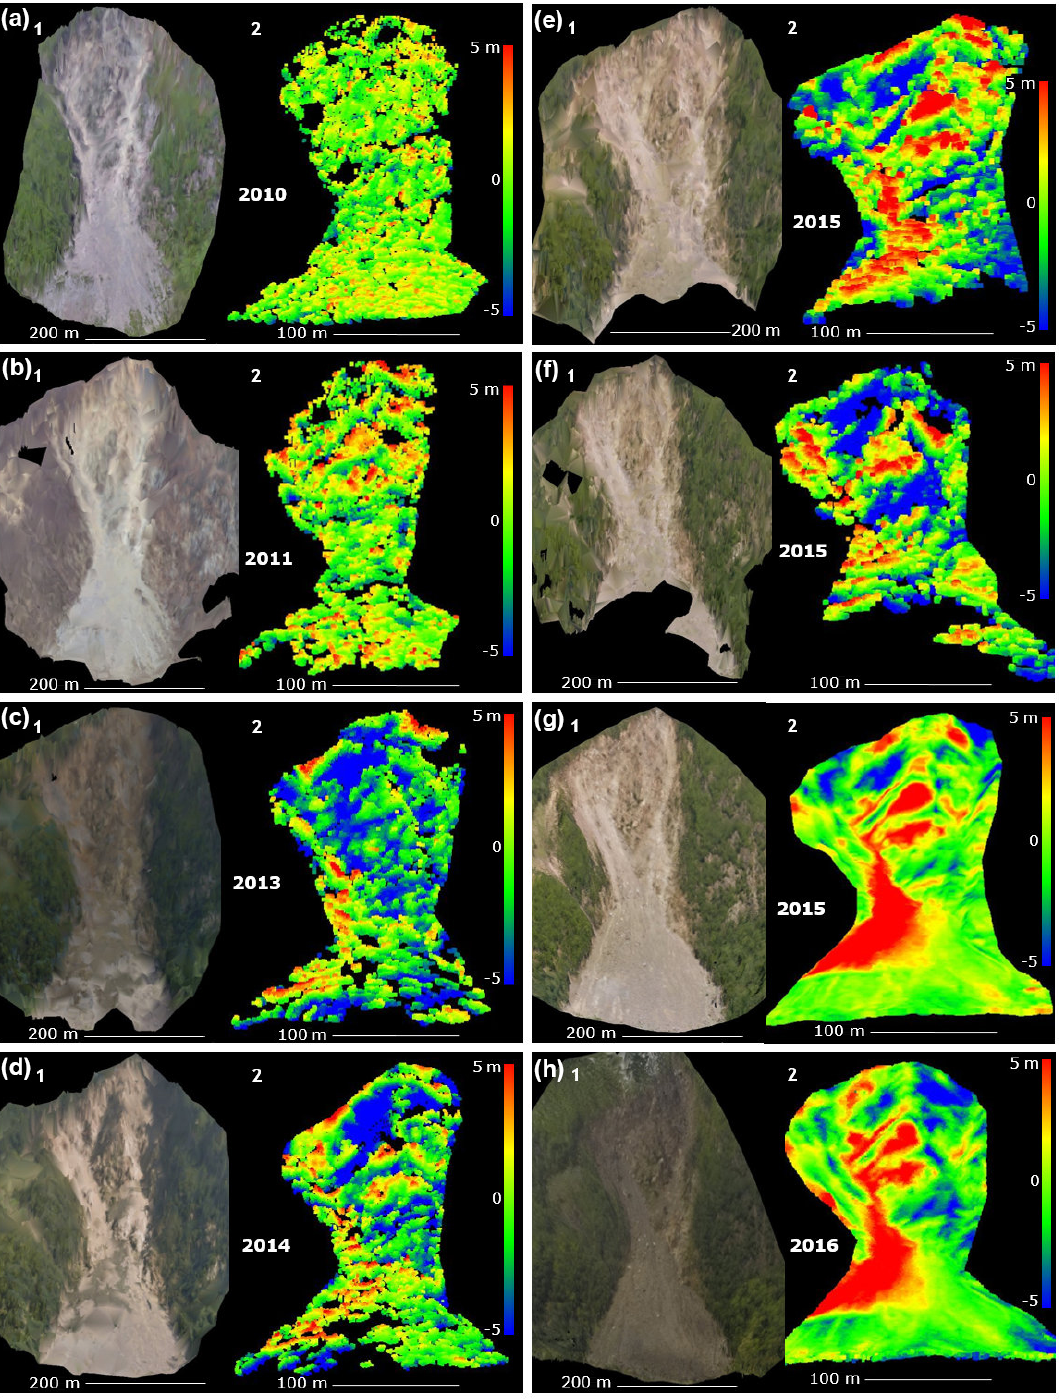
Figure 5. Results at site 2, Séchilienne. Eight point clouds from different image sets taken at six different time with three different image sources and processed with two different programs. (a1–h1) Meshs resulting from the respective point clouds. (a2–h2) Point cloud compar- ison with a 50cm lidar digital elevation model from 2010 (red points is material increase; blue points are material decrease from the 2010 lidar cloud) with the point-to-mesh strategy in CloudCompare. The information on the picture source, date, point density and program used is given in Table